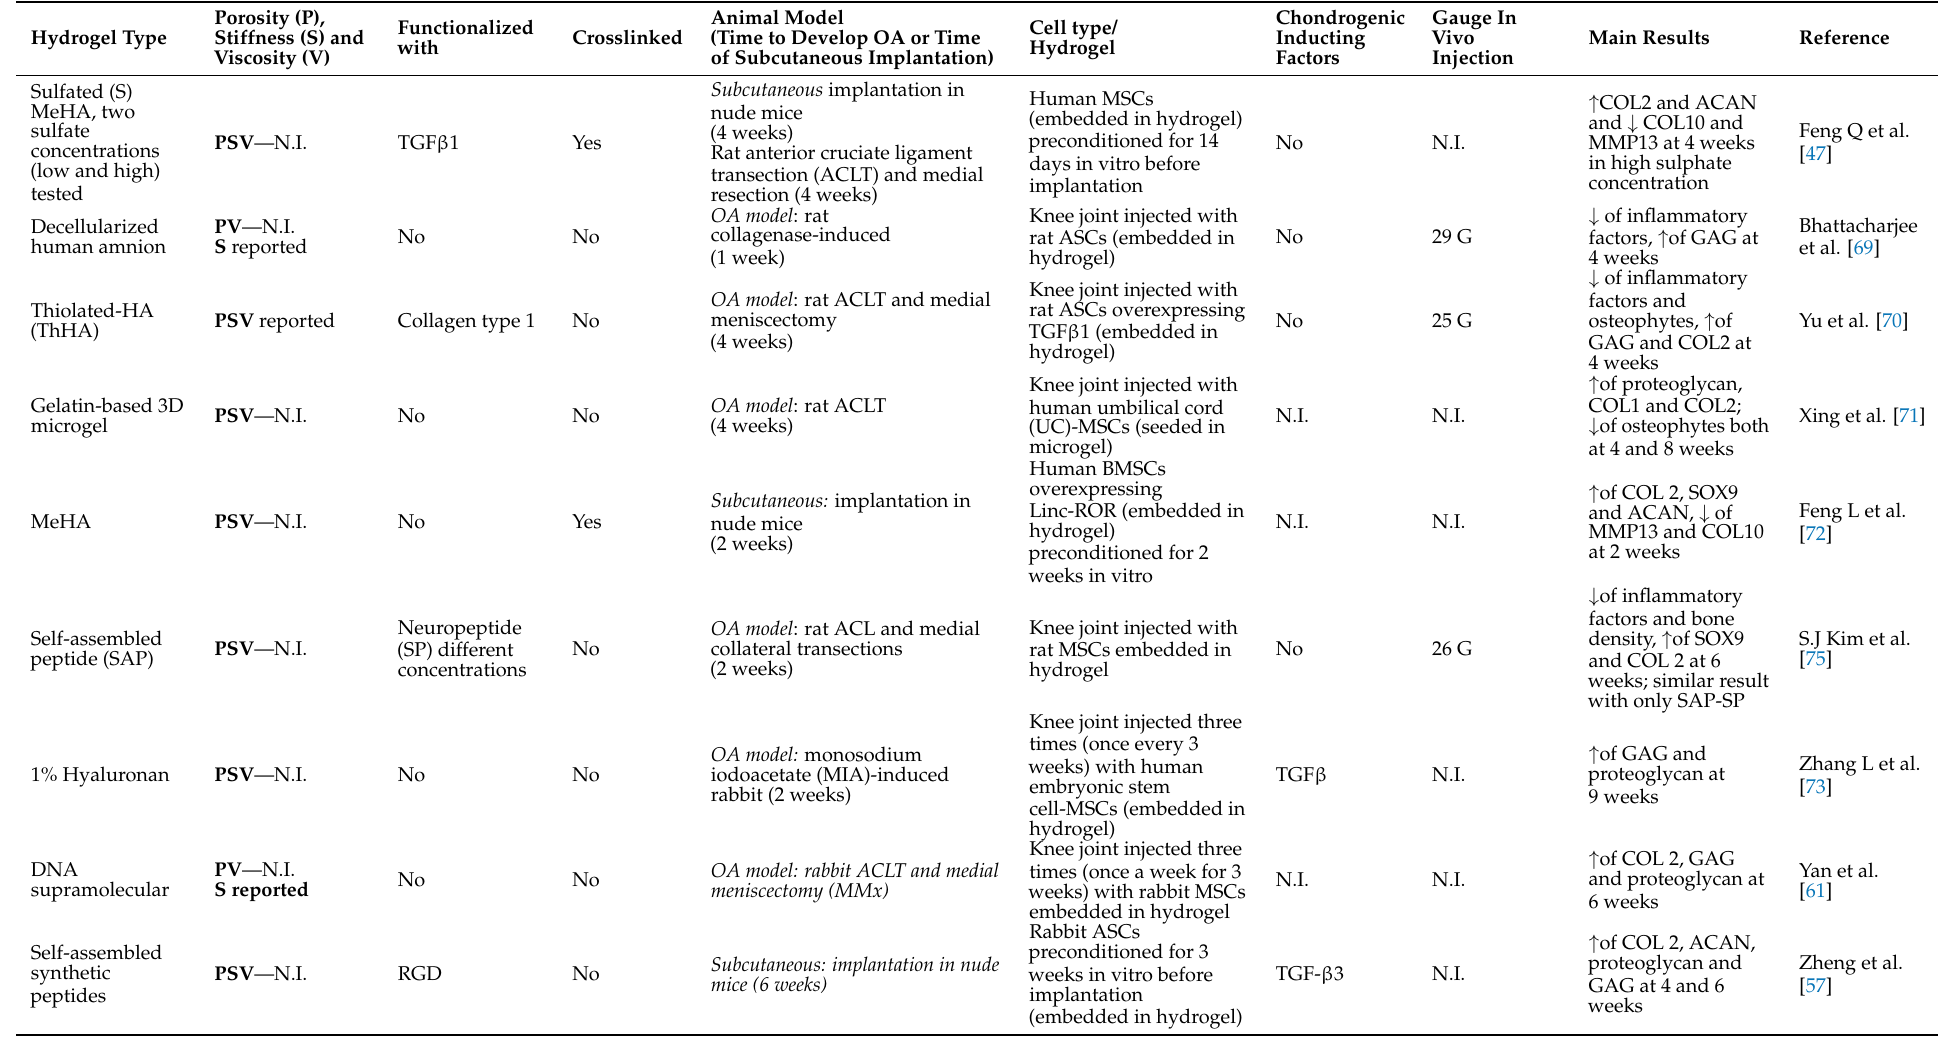
Table 3. Summary of the main results of selected in vivo